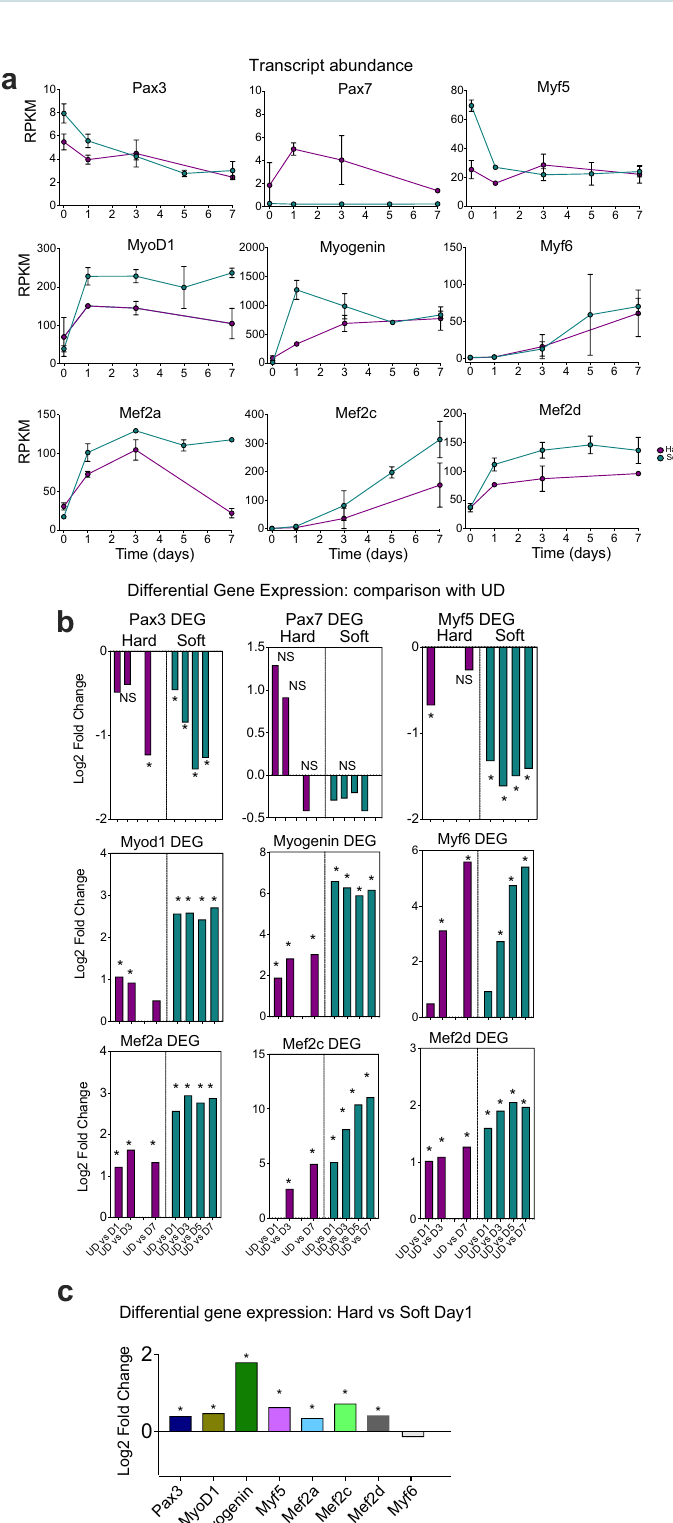
Figure 3. Expression of myogenic factors on hard or soft surfaces in C1F cells. ( a ) RPKM values (reads per kilo base per million mapped reads: transcript abundance) plots for hard (magenta) and soft (green) surfaces over time. Day 0 (D0) represents undifferentiated cells (UD). Days 1–7 represent the time course of differentiation. Error bars show the standard deviation (S.D.). ( b ) Differential gene analysis (DEG) that compares expression for a specific gene on each day of differentiation (D1-7) to undifferentiated cells (UD) for cells cultured on hard and on soft surfaces. *Indicates significant change in log 2 fold expression (p adj value < 0.05). ( c ) Differential gene analysis that compares expression levels of each gene directly for hard versus soft surfaces, at each time point (from UD to D7). *Indicates significant change in log 2 fold expression (p adj value <